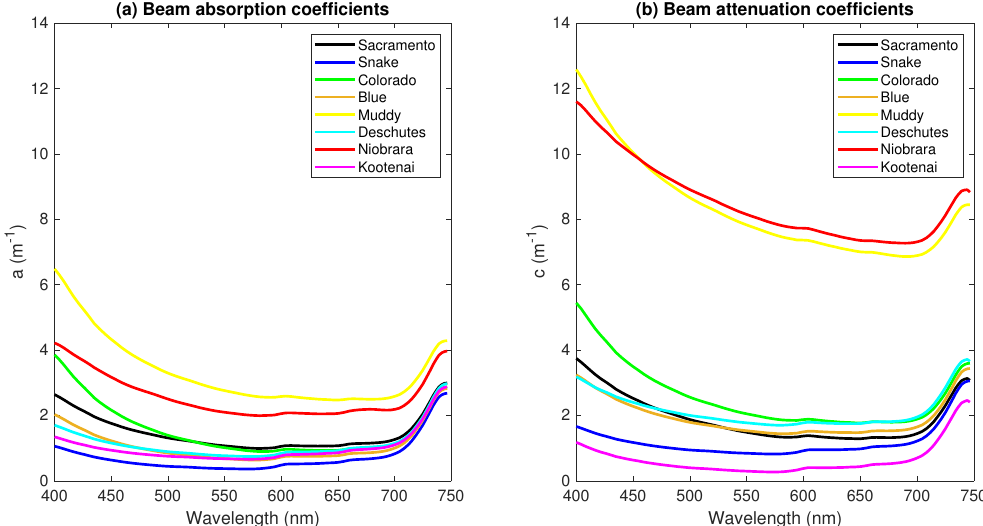
Figure 3. Inherent optical properties of the water column measured on the Kootenai River along with similar data from seven other rivers throughout the western USA for comparison. ( a ) beam absorption coefficients a ( λ ) ; ( b ) beam attenuation coefficients c ( λ ) .